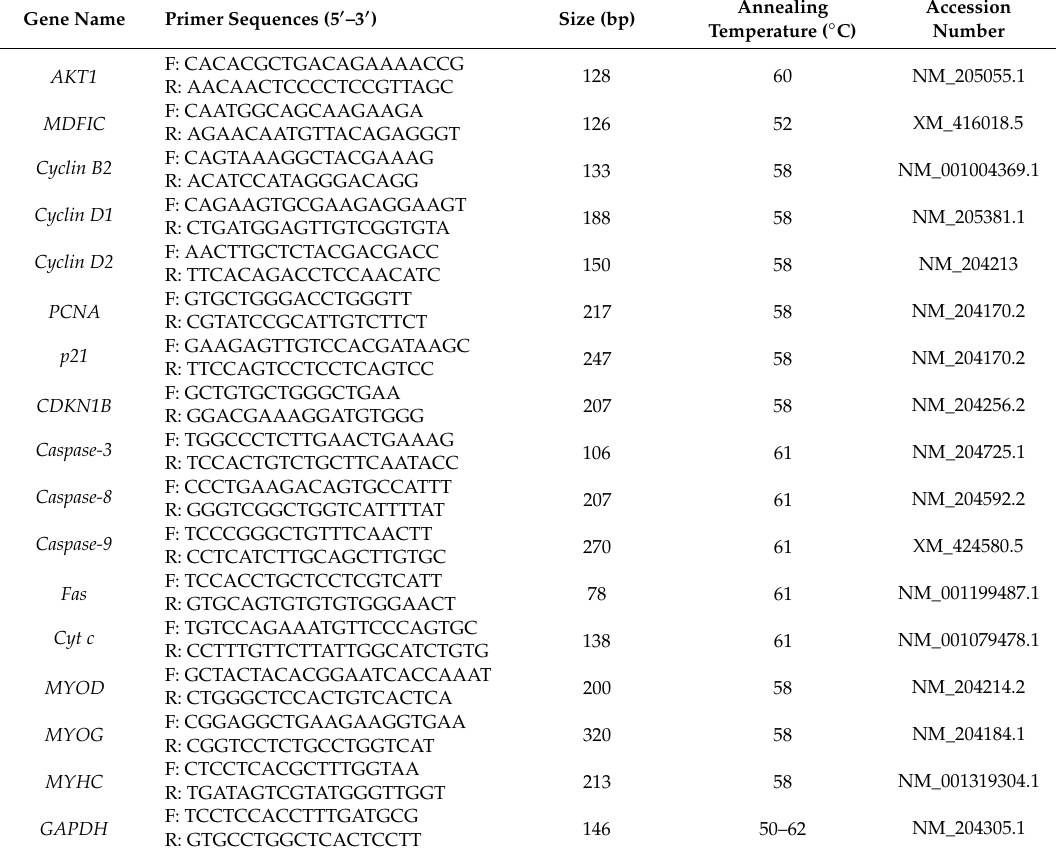
Table 1. Primers used for